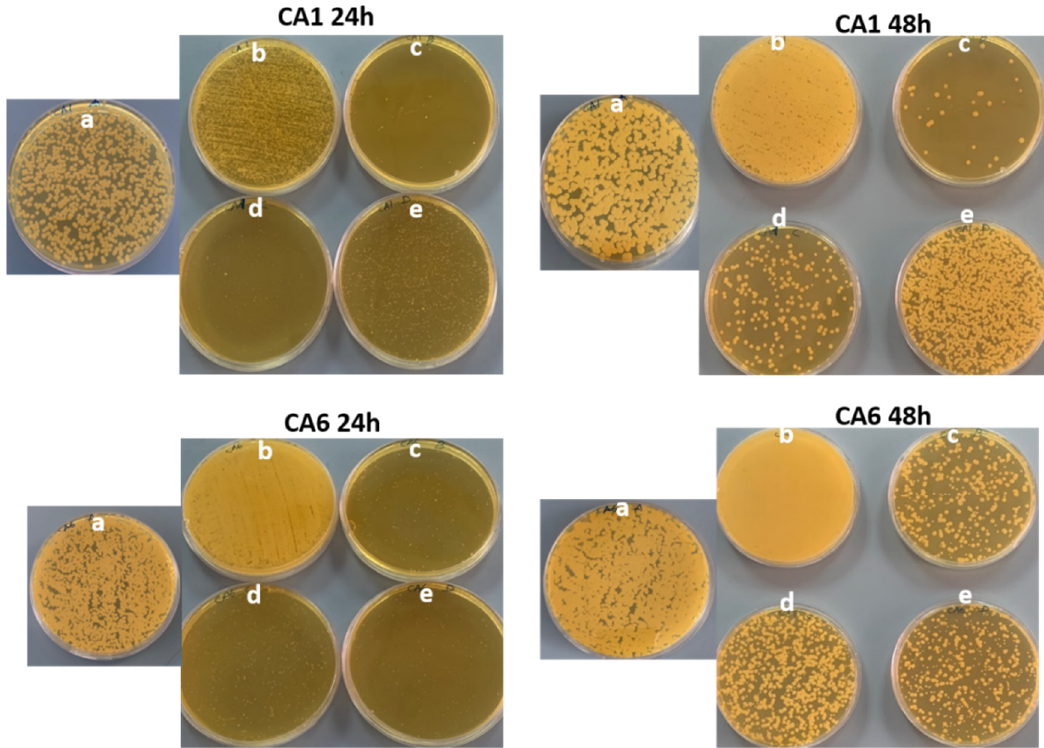
Figure 10. Representative agar plate images of two C. auris strains showing the effect of synthesized nanomaterial on the biofilm formation obtained by CFU technique. ( a ) Control (untreated); ( b ) Ti- ZSM-5; ( c ) Ag-silicate-1; ( d ) 4 wt%Ag/TiZSM-5; ( e ) AgNO 3 .